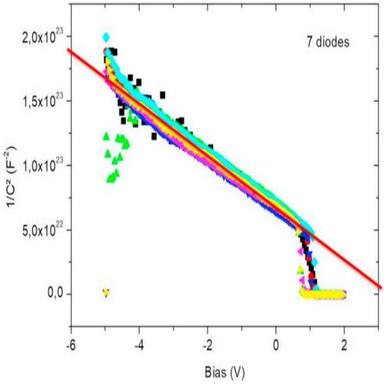
1/C2 - V curves of 7 diodes from all over the sample and in red the linear fit. (For interpretation of the references to colour in this figure legend, the reader is referred to the web version of this article.)